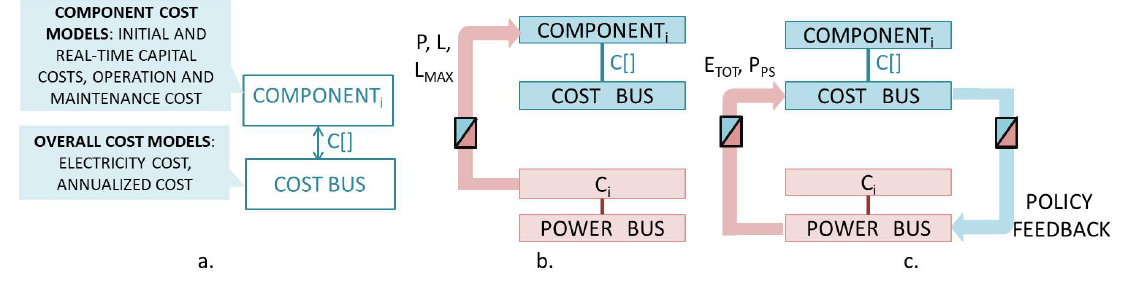
Figure 2. Organization of the cost layer: property-specific signals ( a ), inter-layer signals shared by models of the same component ( b ), and with the power bus ( c